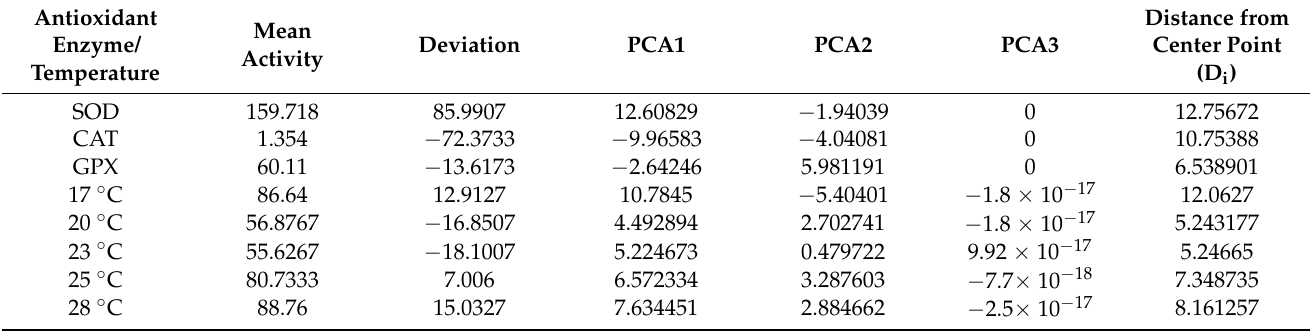
Table 6. GGE biplot analysis results for antioxidant enzyme activities in different temperature